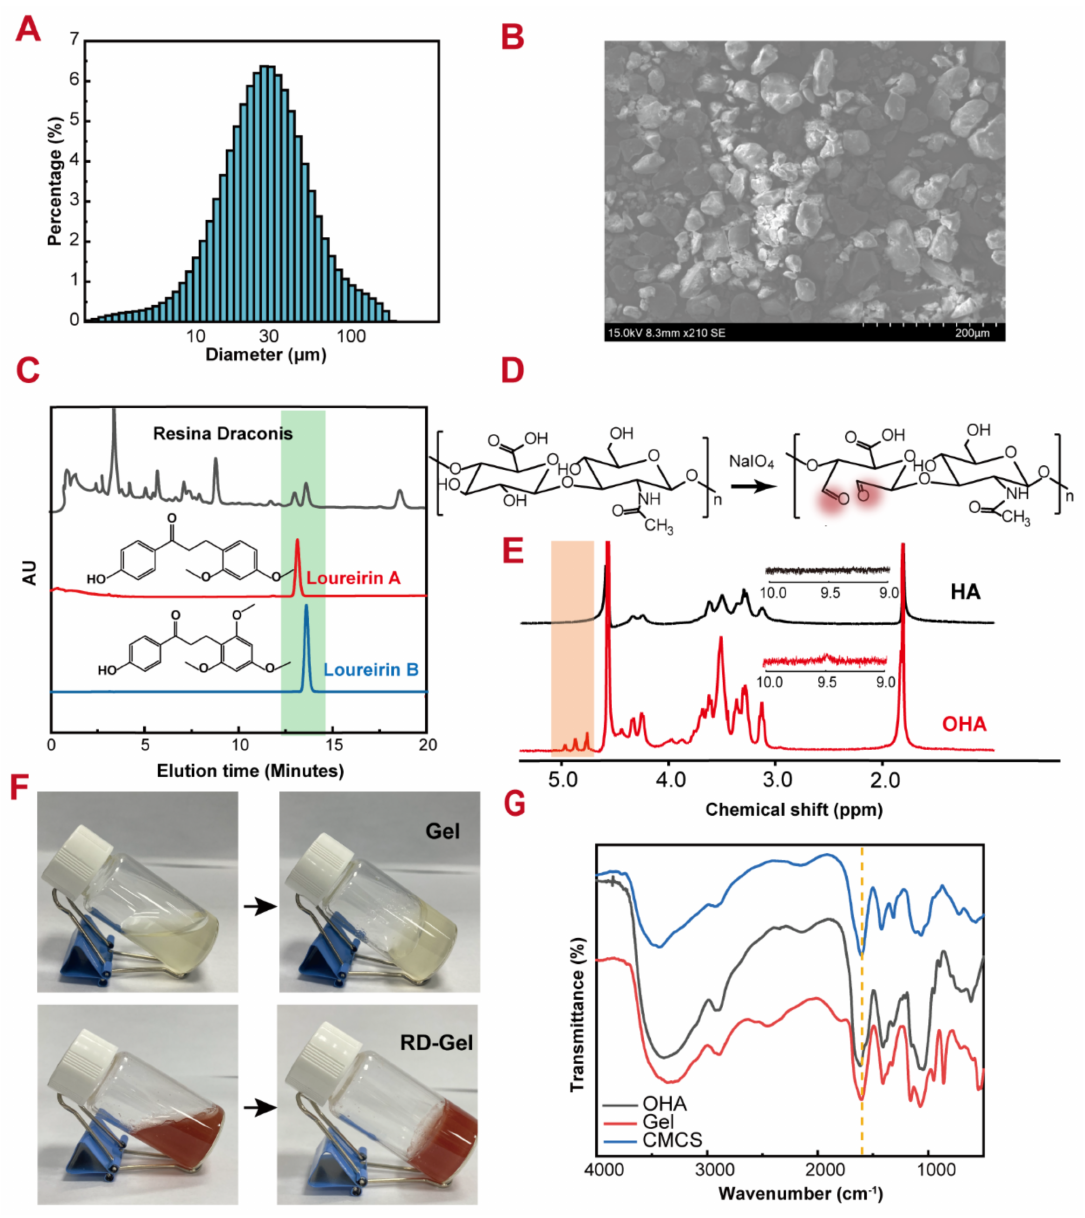
Figure 1. Characterizations of Resina Draconis and synthesized hydrogels. ( A ) Particle size distri- bution of Resina Draconis. ( B ) SEM image of Resina Draconis. ( C ) Liquid chromatogram of Resina Draconis, Loureirin A and B. ( D ) Synthesis route of OHA. ( E ) 1 H-NMR spectra of HA. ( F ) Formation of Gel and RD-Gel. ( G ) FT-IR spectra of OHA, CMCS, and the formed